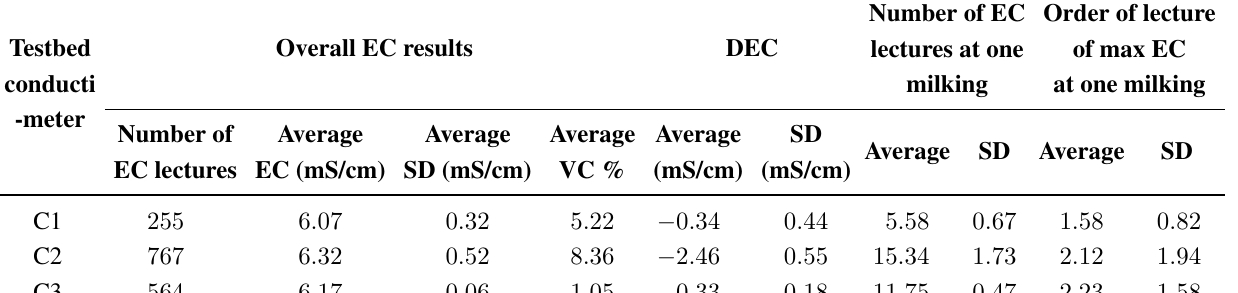
Table 3. Electrical conductivity measurements, deviations from reference, number of at on-line testbed experiment.